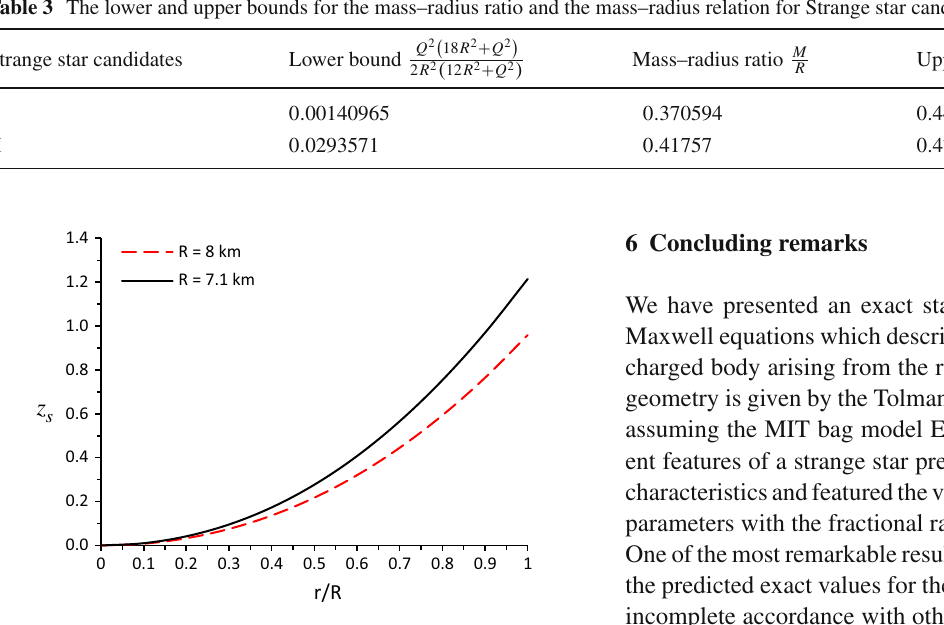
Fig. 8 Behavior of surface redshift function ( z s ) versus radial coor- dinates r / R . For plotting of this figure, the corresponding values of arbitrary constants or parameters are displayed in Table 1